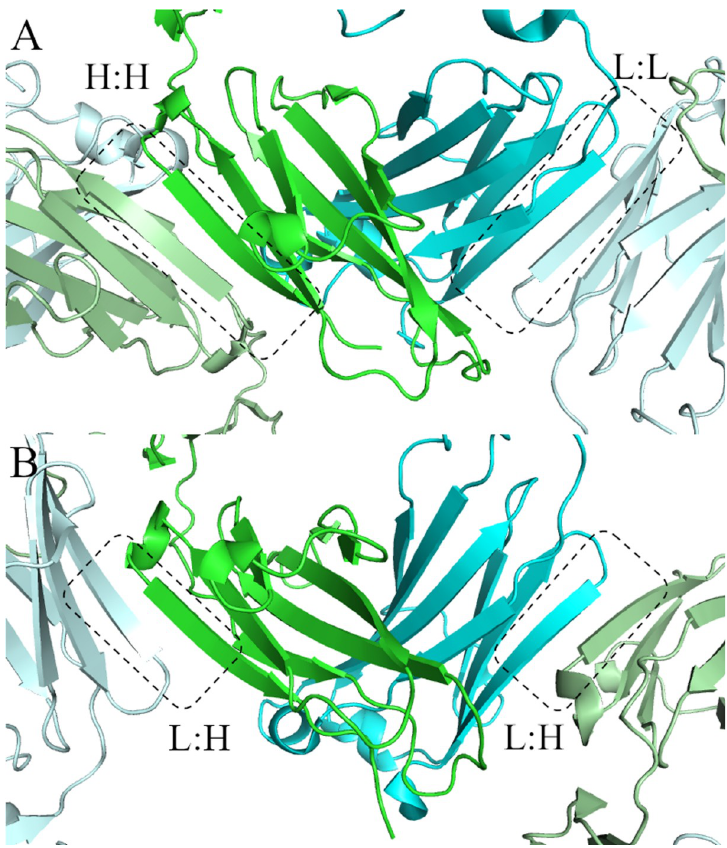
Fig 1. Examples of G-strand beta sheet packing in rabbit Fab crystal structures. (A) HC:HC and LC:LC beta packing in 4ZTO.pdb [12]. Heavy chain in green and pale green. Light chain in Cyan and pale cyan. (B) HC:LC beta packing in 4JO1.pdb [13]. Figures prepared in